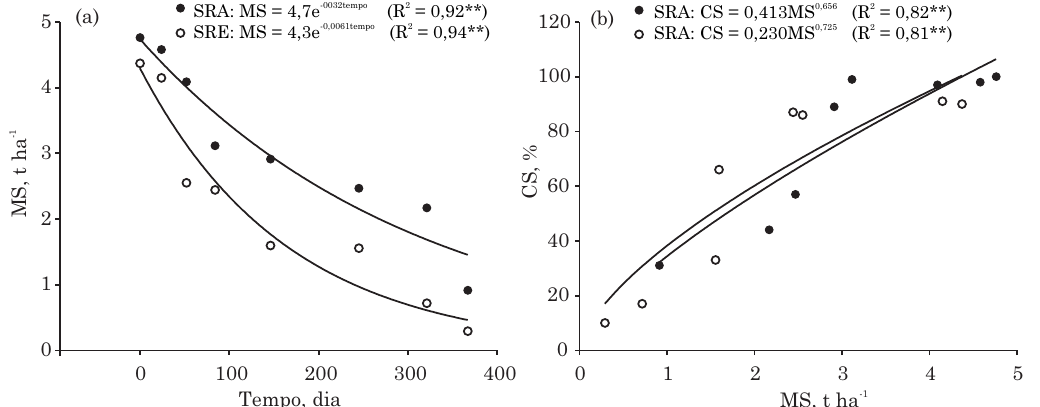
Figura 2. Relação entre a massa vegetal das culturas, MS, e o tempo (a) e relação da cobertura do solo por resíduos culturais, CS, com a massa vegetal das culturas (b), MS, para os tratamentos solo coberto por resíduo de azevém (SRA) e solo coberto por resíduo de ervilhaca